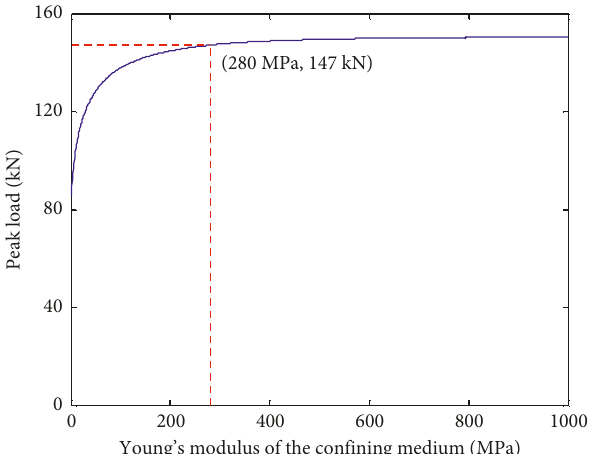
Table 8: Input parameters for the bond-slip model.